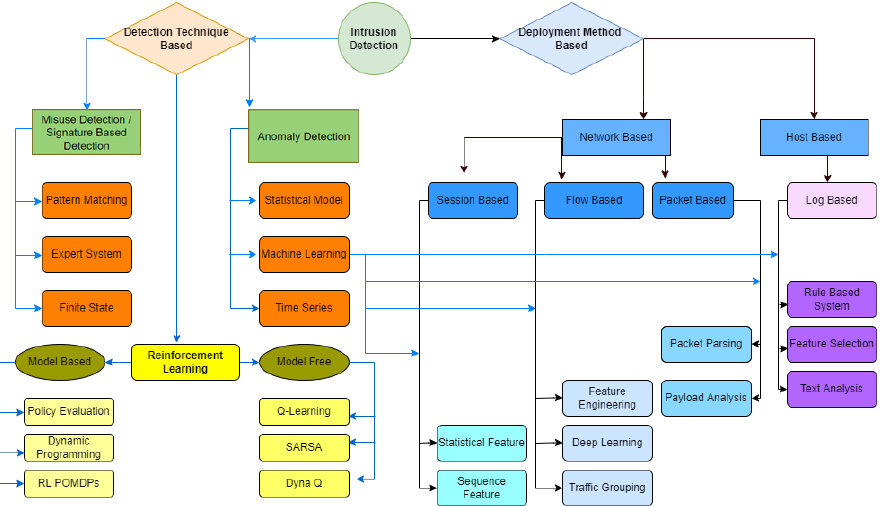
Figure 3. Types of intrusion detection